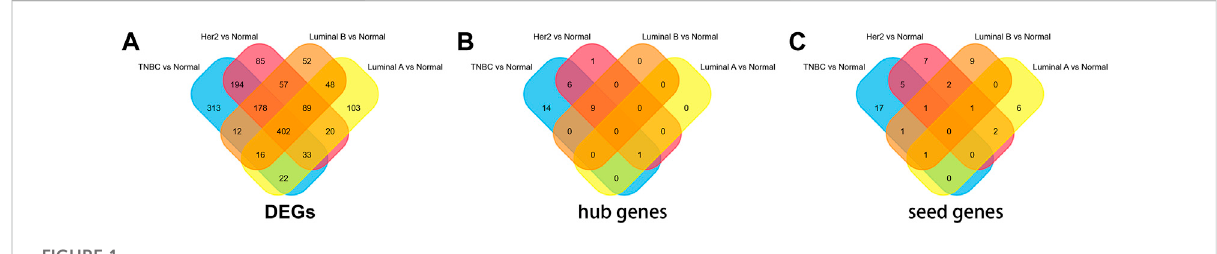
FIGURE 1 Overlapping of (A) DEGs, (B) hub genes, and (C) seed